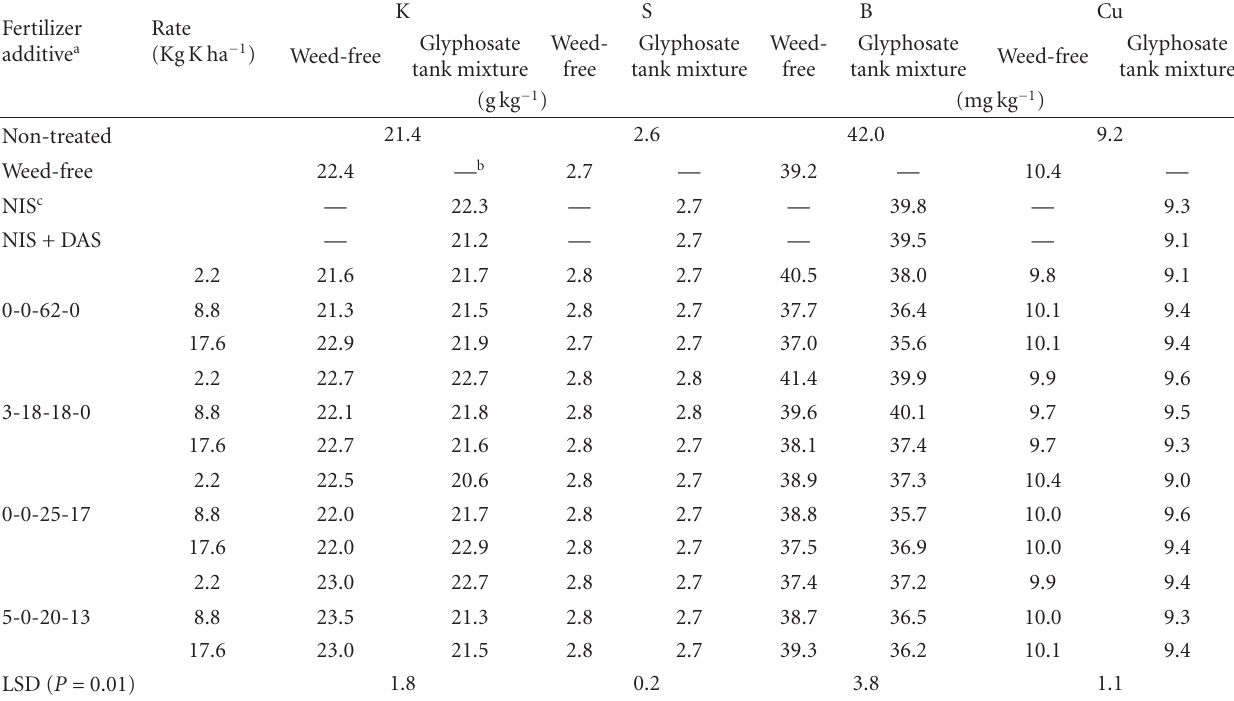
Table 5: Soybean leaf tissue K, S, B, and Cu concentrations 14 days after treatment at Novelty and Malden in 2004 and 2005. Data were combined over